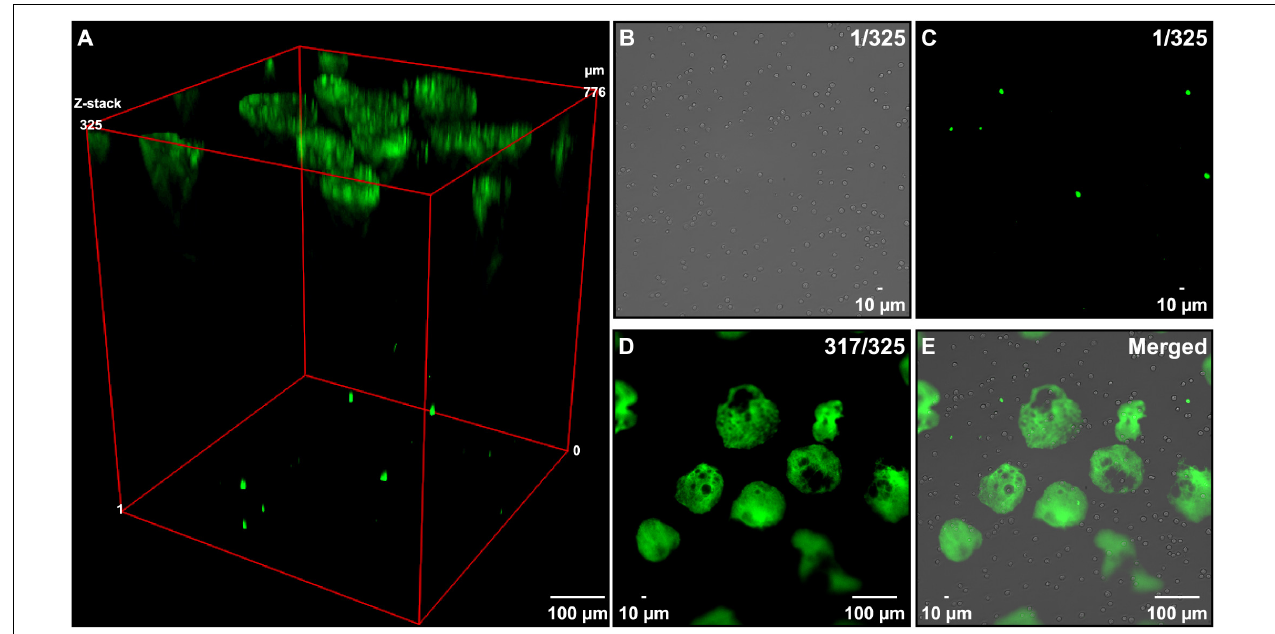
FIGURE 2 | Axial assessment of DNA entities. Nalm-6 cells in serum-free PBS were placed in a 48-well plate and the axial localization of the released DNA was determined by microscopy. (A) Maximum intensity Z-projection of 325 widefield Z-stacks covering the whole focal volume of the liquid in a well (776 µ m). Green fluorescens origin from extracellular DNA stained by the cell membrane-impermeant dye SYTOX Green nucleic stain. (B) Bright-field image of cells in Z-stack 1 out of 325. (C) Fluorescent image of the corresponding image shown in panel (B) representing dead cells. (D) Image of stack 317 out of 325 recorded in the fluorescent channel showing the extracellular DNA released when placing cells in serum-free solutions. (E) An overlay image obtained by combining images shown in panels (B–D)